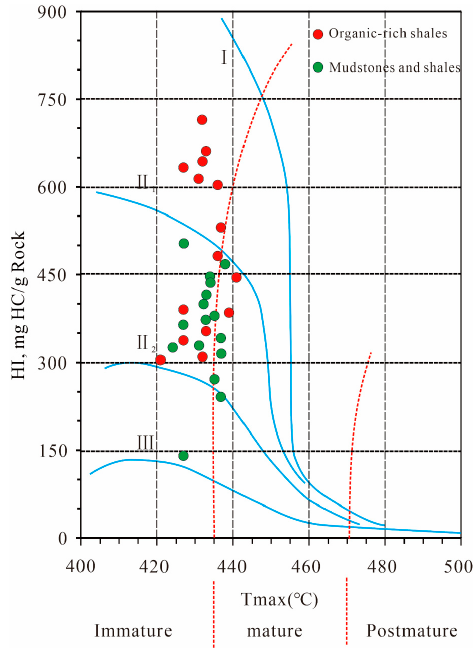
Figure 8. Cross-plot of HI vs. T max values showing the organic ma tt er types for source rock samples from LS2 of the Weixinan Sag, Beibuwan Basin (I: type I kerogen; II 1 : type II 1 kerogen; II 2 : type II 2 kerogen; III: type III kerogen).